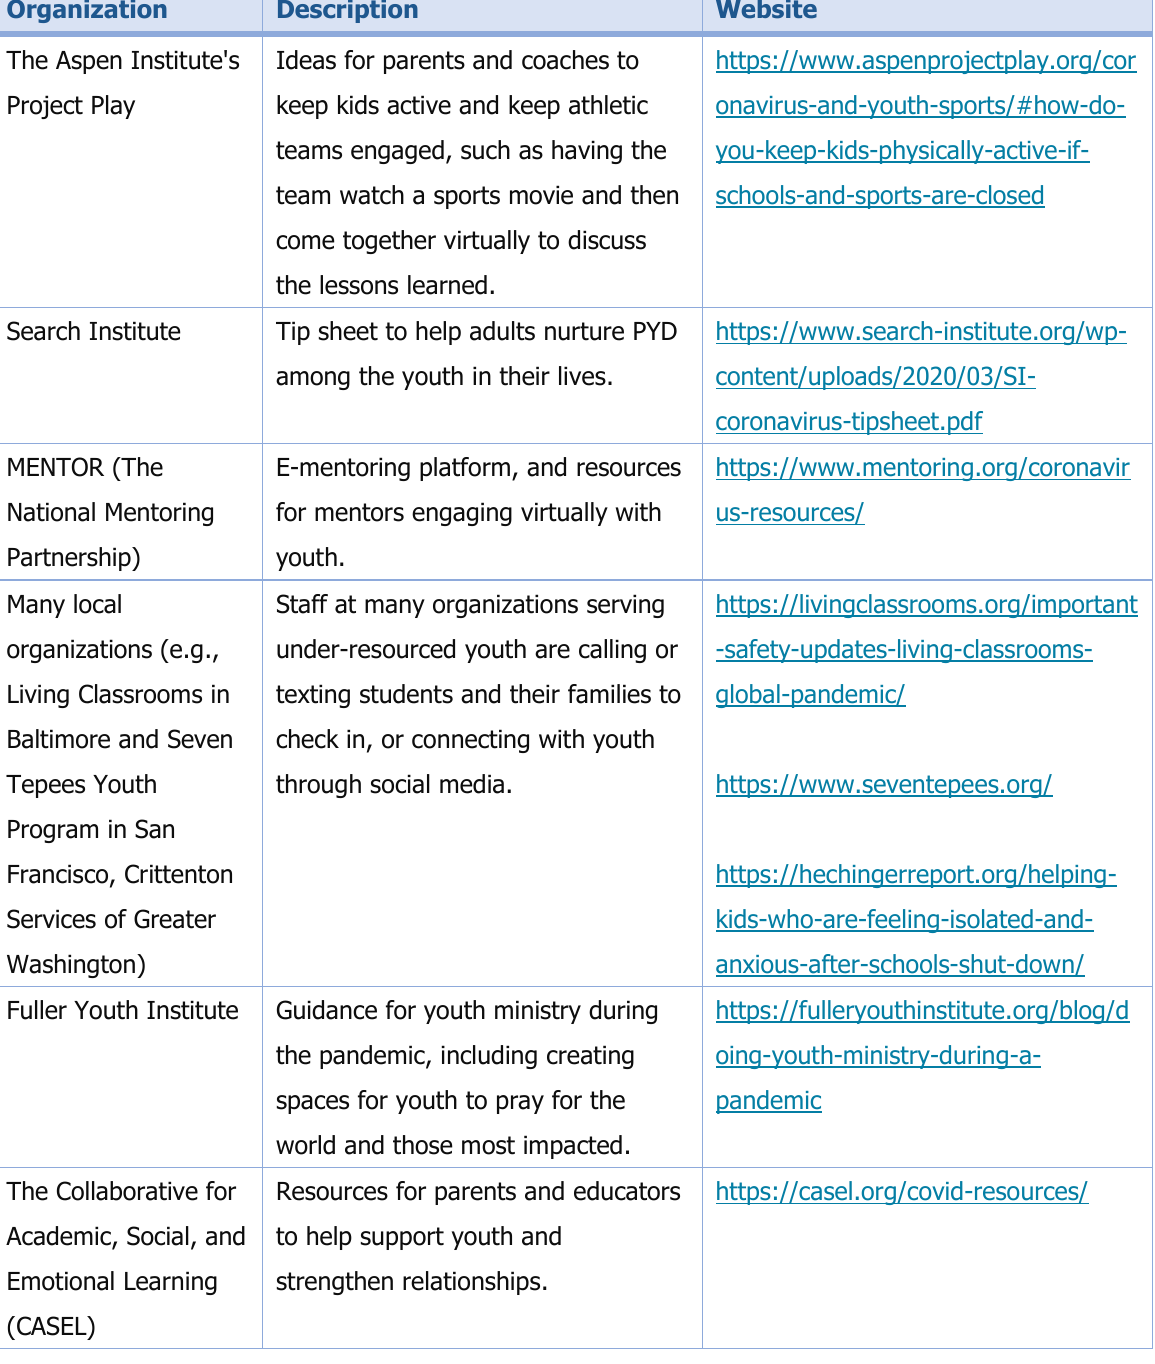
Table 1. Supporting Youth-Adult Relationships During the COVID-19 Pandemic